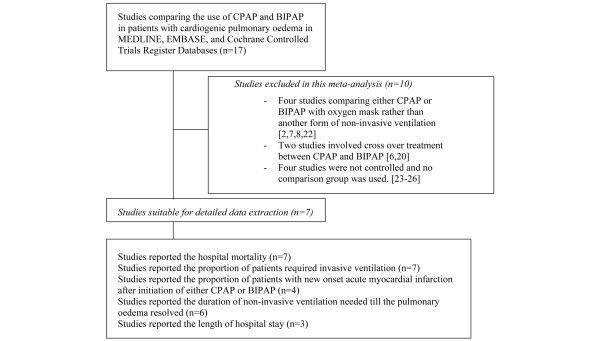
Flow chart: study inclusion and exclusion in the meta-analysis. BiPAP, bi-level positive airway pressure; CPAP, continuous positive airway pressure.